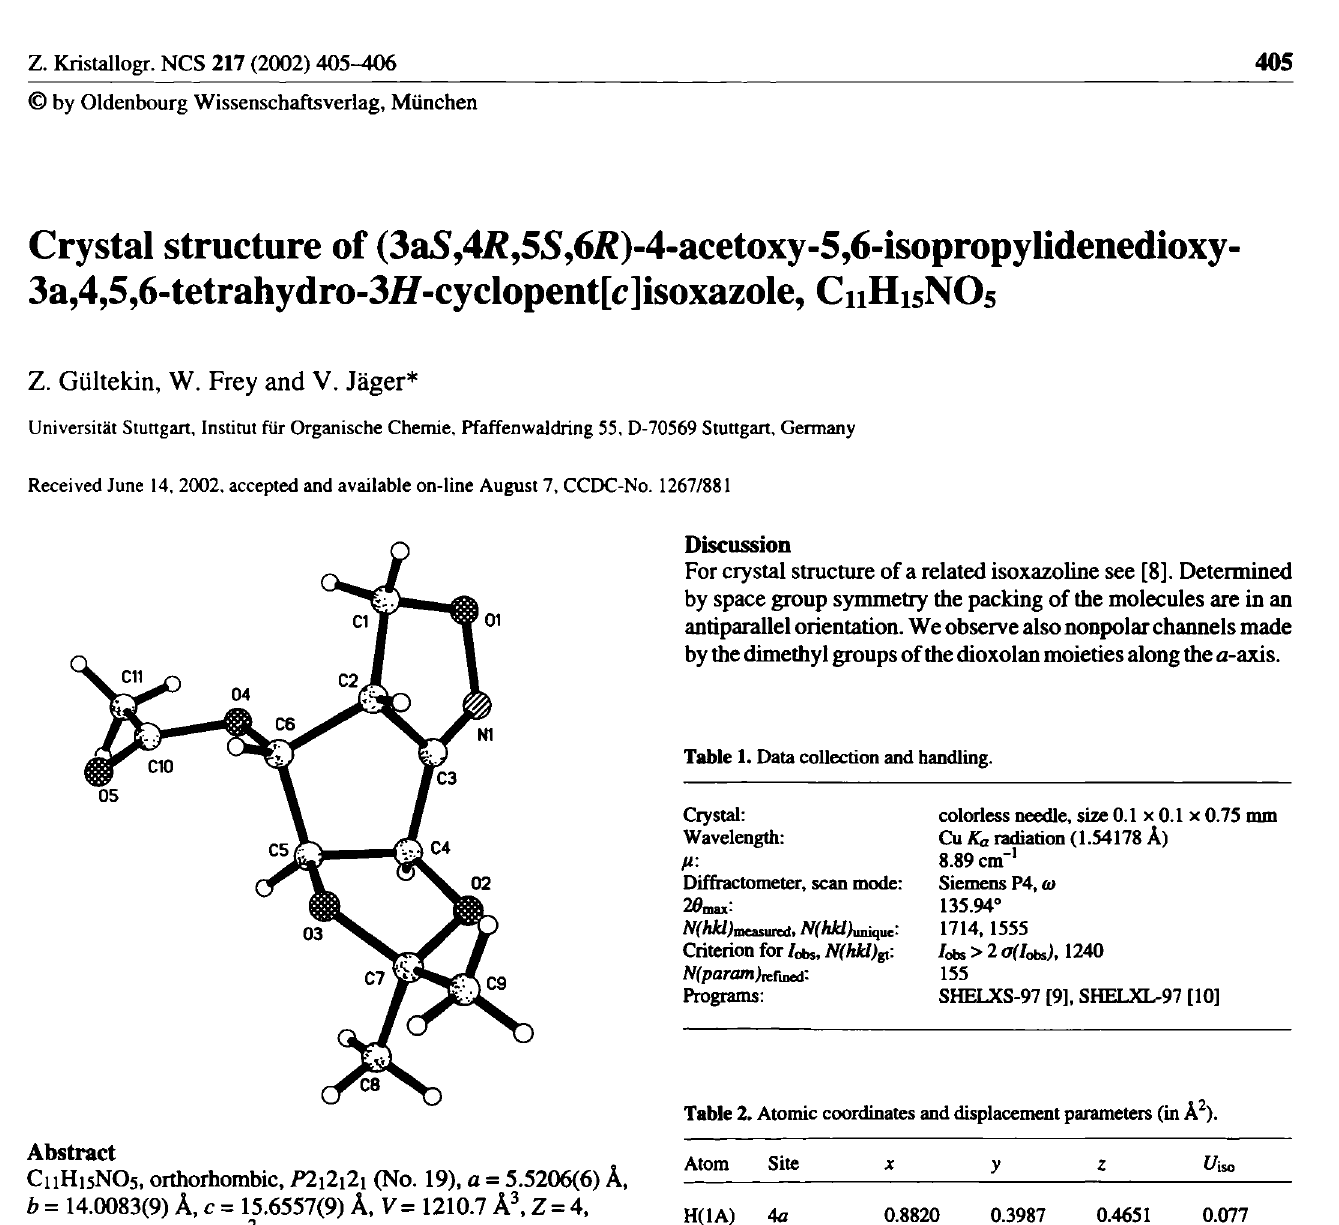
Table 2. Atomic coordinates and displacement parameters (in Â 2